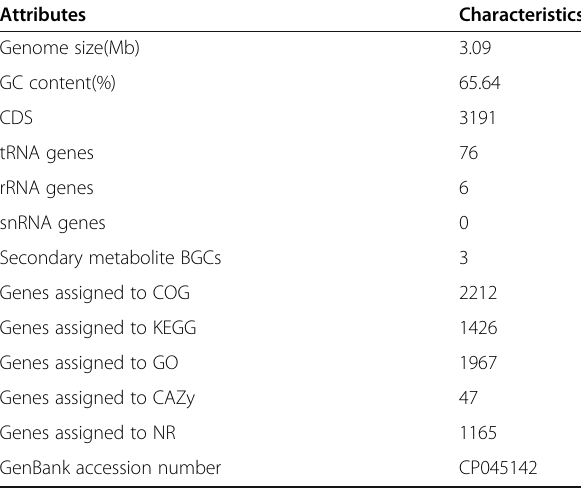
Table 1 Overview of genomic features of Halomicrobium